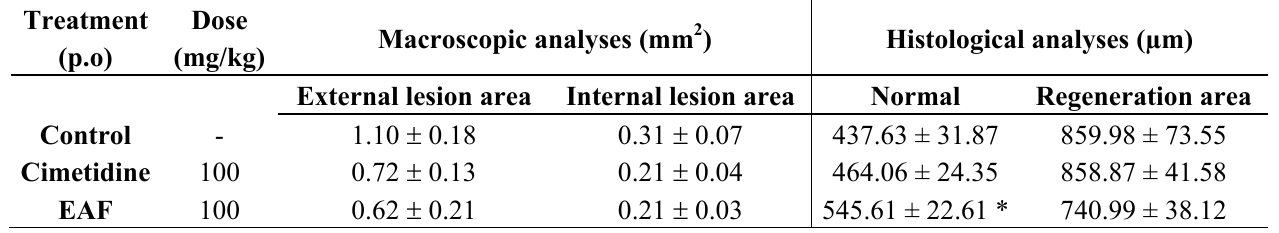
Table 2. Effects of the 14-day treatment with ethyl acetate fraction (EAF) from Alchornea stomachs of